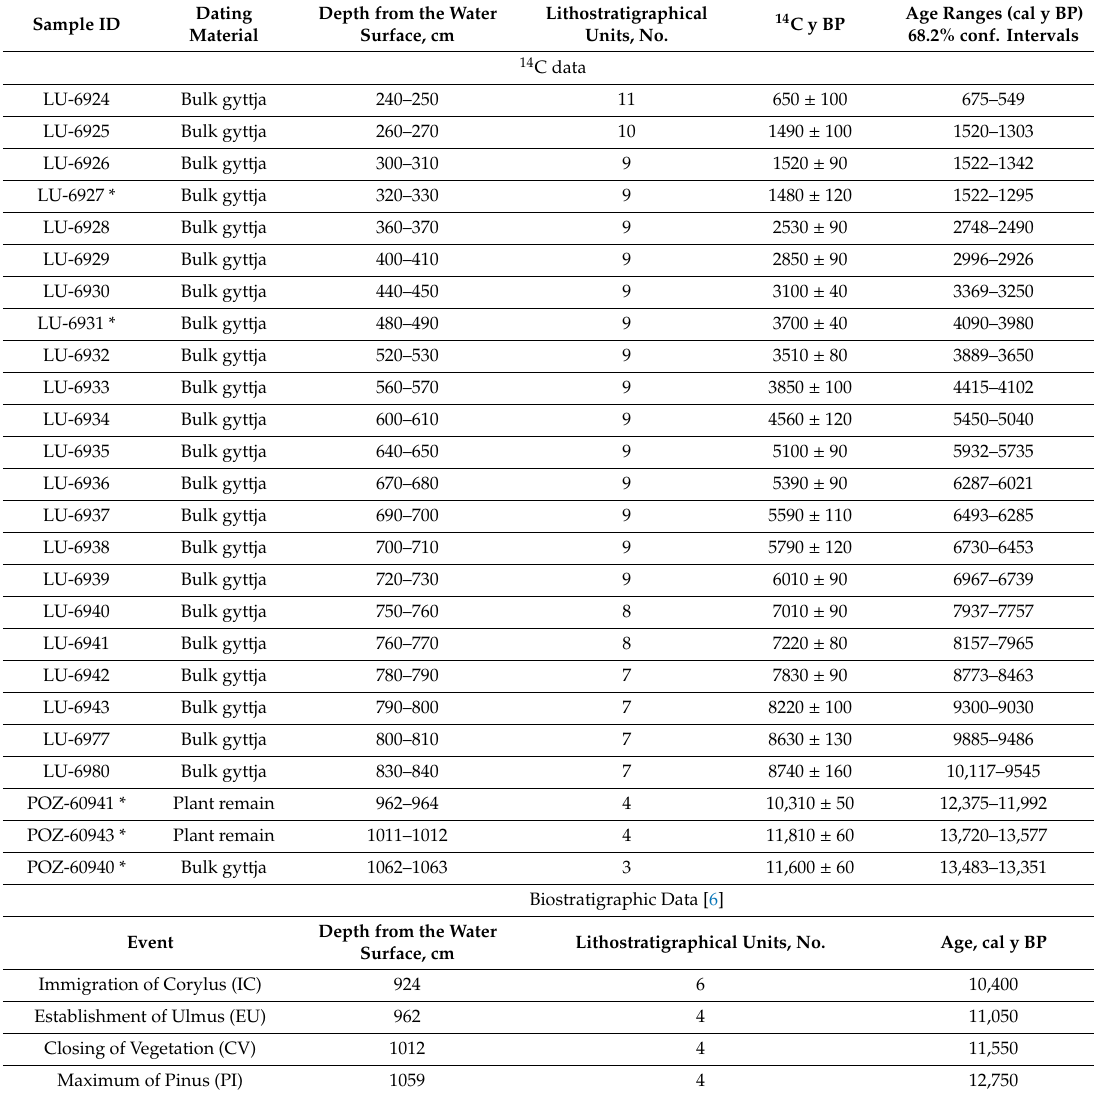
Table 3. AMS, radiocarbon, and biostratigraphic data and calibrated age ranges for Kamyshovoye